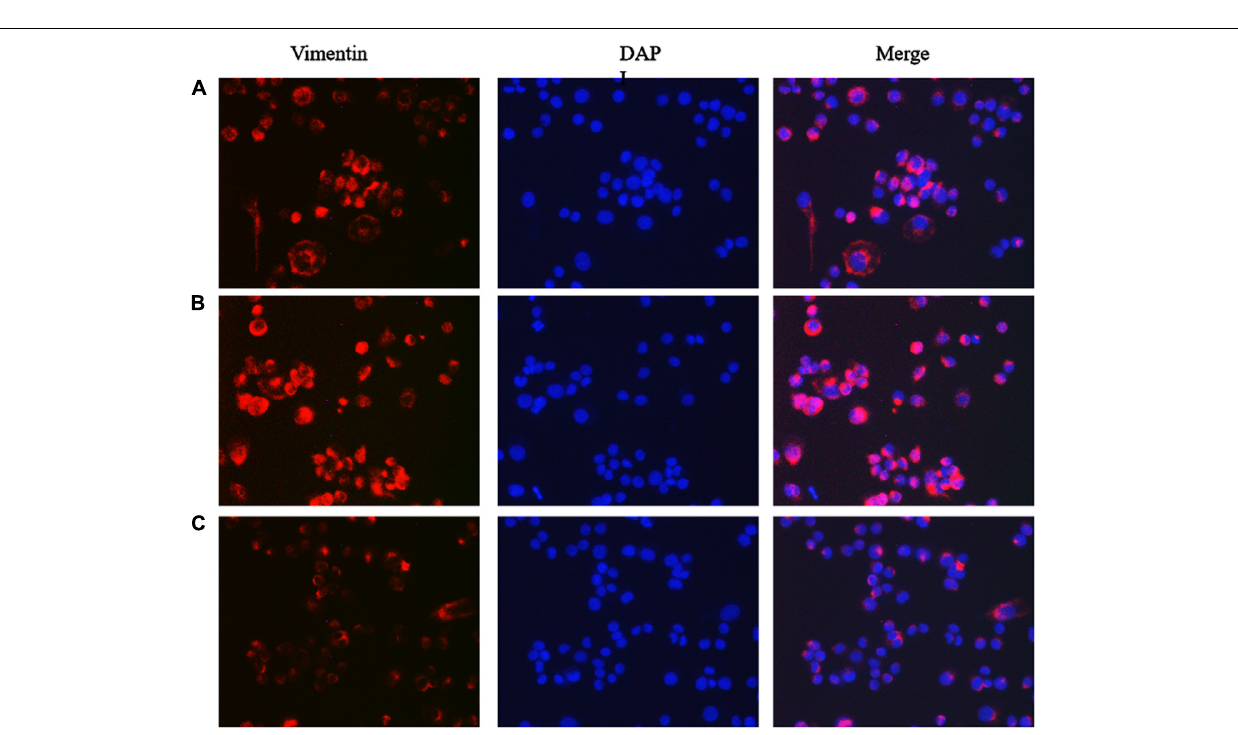
FIGURE 6 | The effect of lncRNA TPA overexpression and knockdown on MCF-7 Vimentin protein expression [200 × , (A) Normal breast cancer cells, (B) lncRNA TPA overexpression cells, (C) lncRNA TPA knockdown cells].